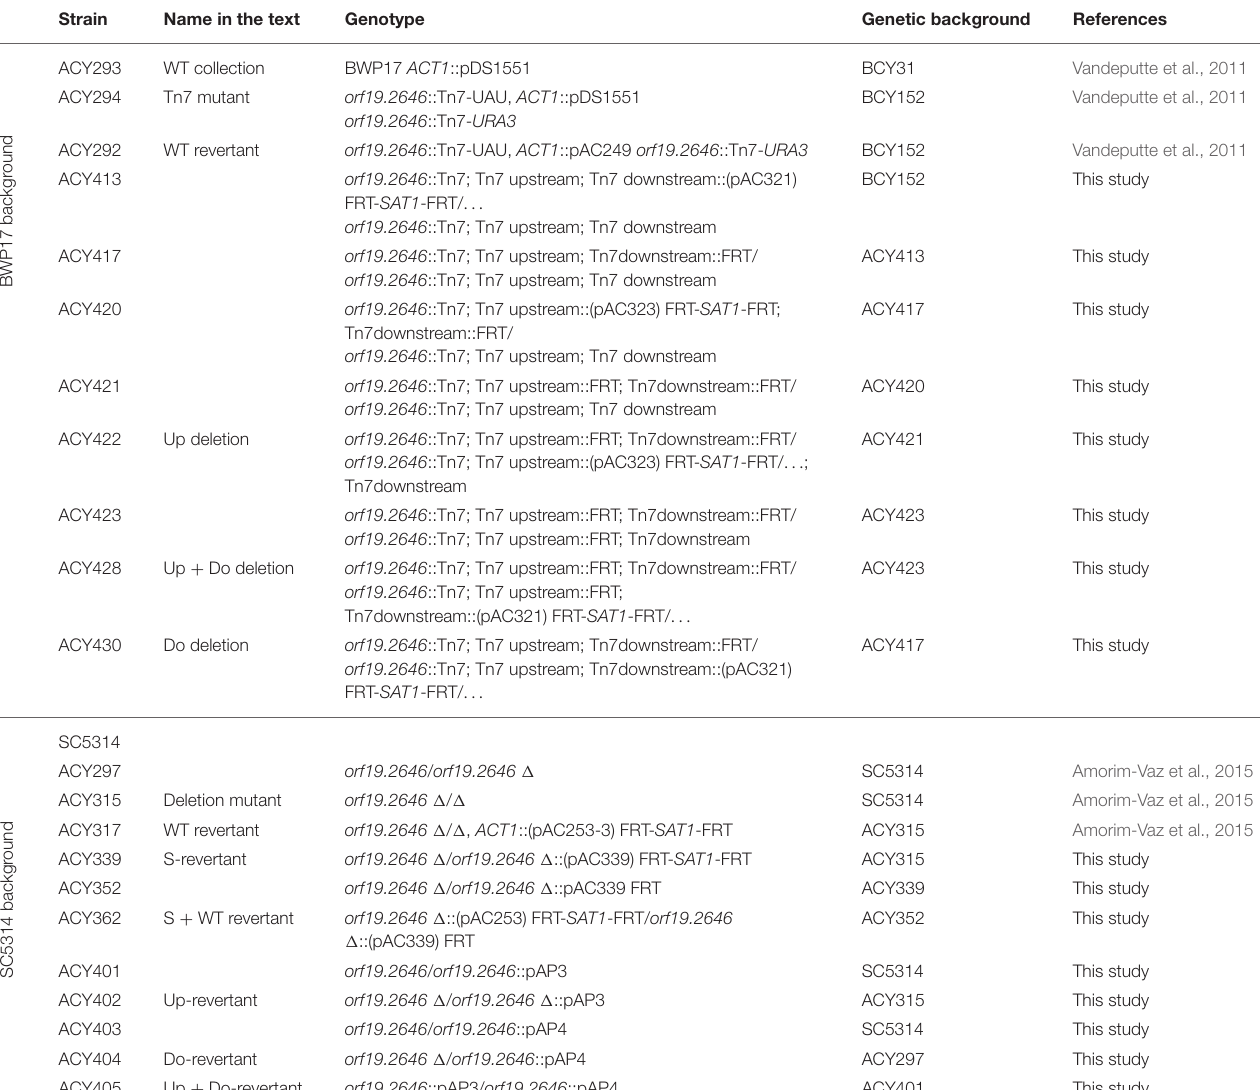
TABLE 1 | List of